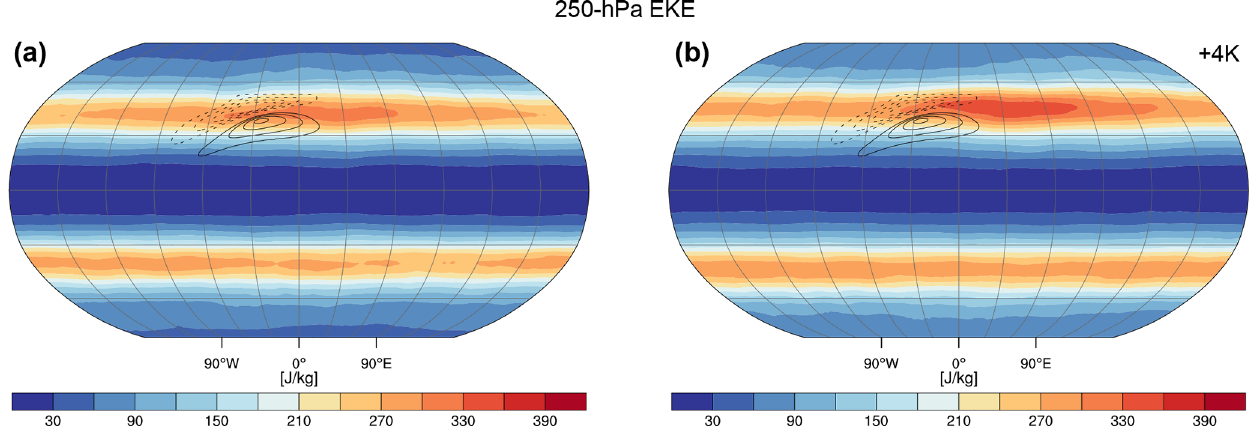
Figure 1. Eddy kinetic energy (shading; Jkg − 1 ) at the 250hPa level for the (a) Qobs control run with SST front in the Northern Hemisphere and (b) with homogeneous warming by 4K at the surface. The SST front is indicated in this and the following figures by its imprint in the 2m temperature after removing the zonal mean (black solid contours indicate positive values and dashed negative values; starting at ± 0.5K in steps of